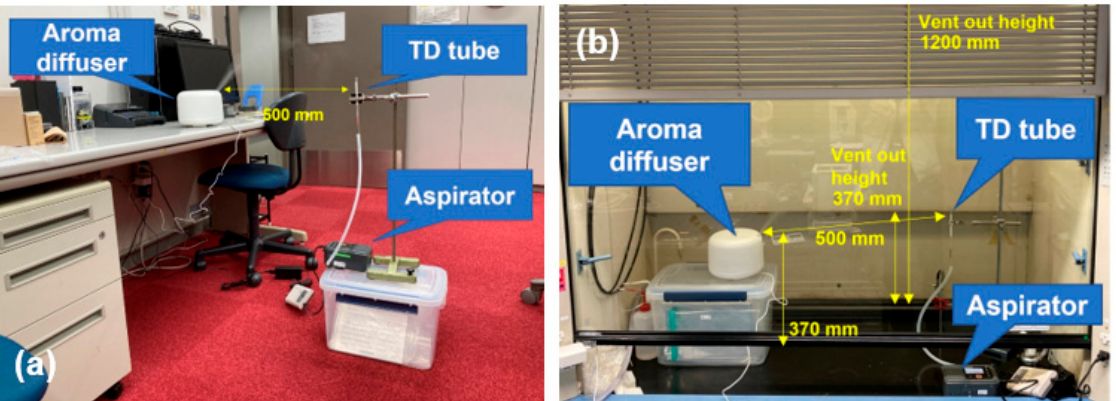
Figure 4. Schedule of collecting air, including diffused essential oils and effective components by TD tubes.